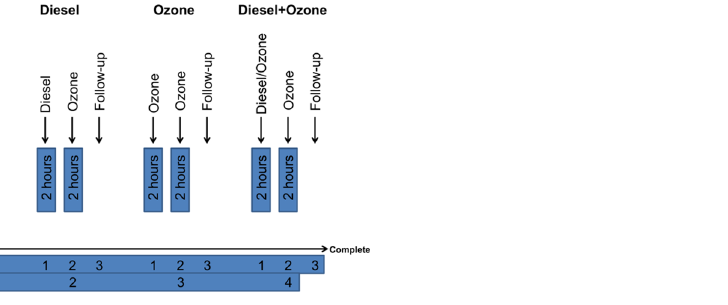
Fig 1. Exposure schedule for volunteers.Each exposure arm is composed of three days. Day 1 is one of the four exposures (clean air, DE, O 3 , or DE+O 3 ), Day 2 is always O 3 , and Day 3 has no